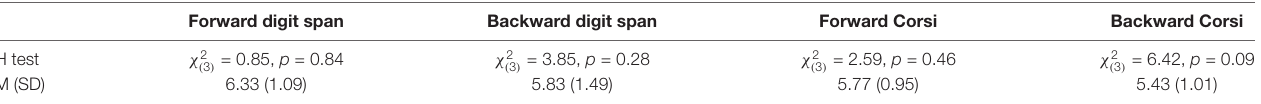
TABLE 1 | Kruskal-Wallis H